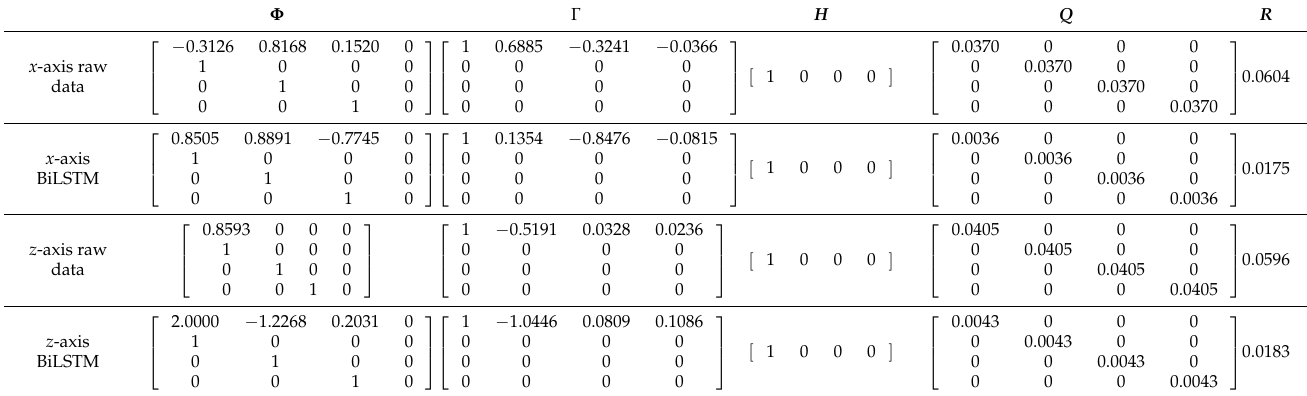
Table 8. Kalman filter parameters of all measurements.